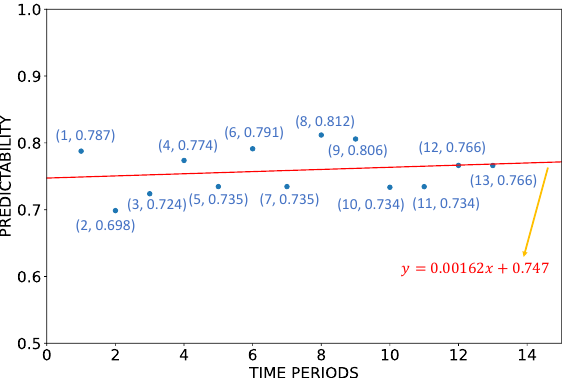
Figure 7. One example of calculating the gradient of SST predictability in ( 57 ◦ S–60 ◦ S, 60 ◦ E–63 ◦ E) using the method of least